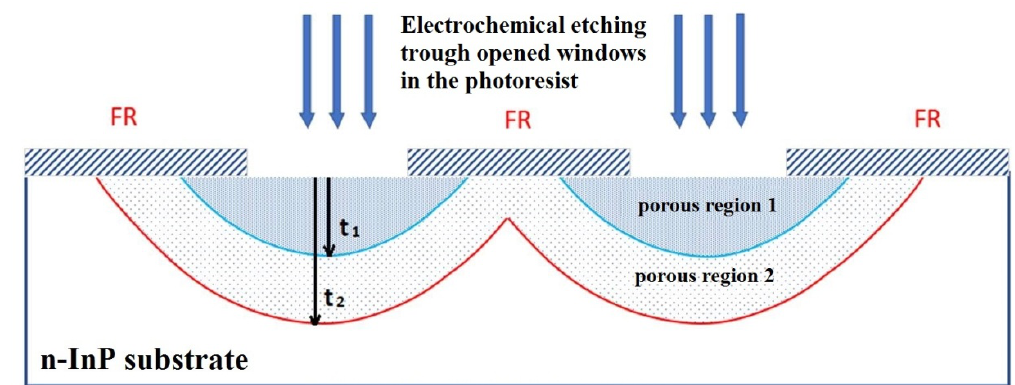
Figure 4. Schematic representation of the time evolution of porous layer in depth and under the protected by photoresist